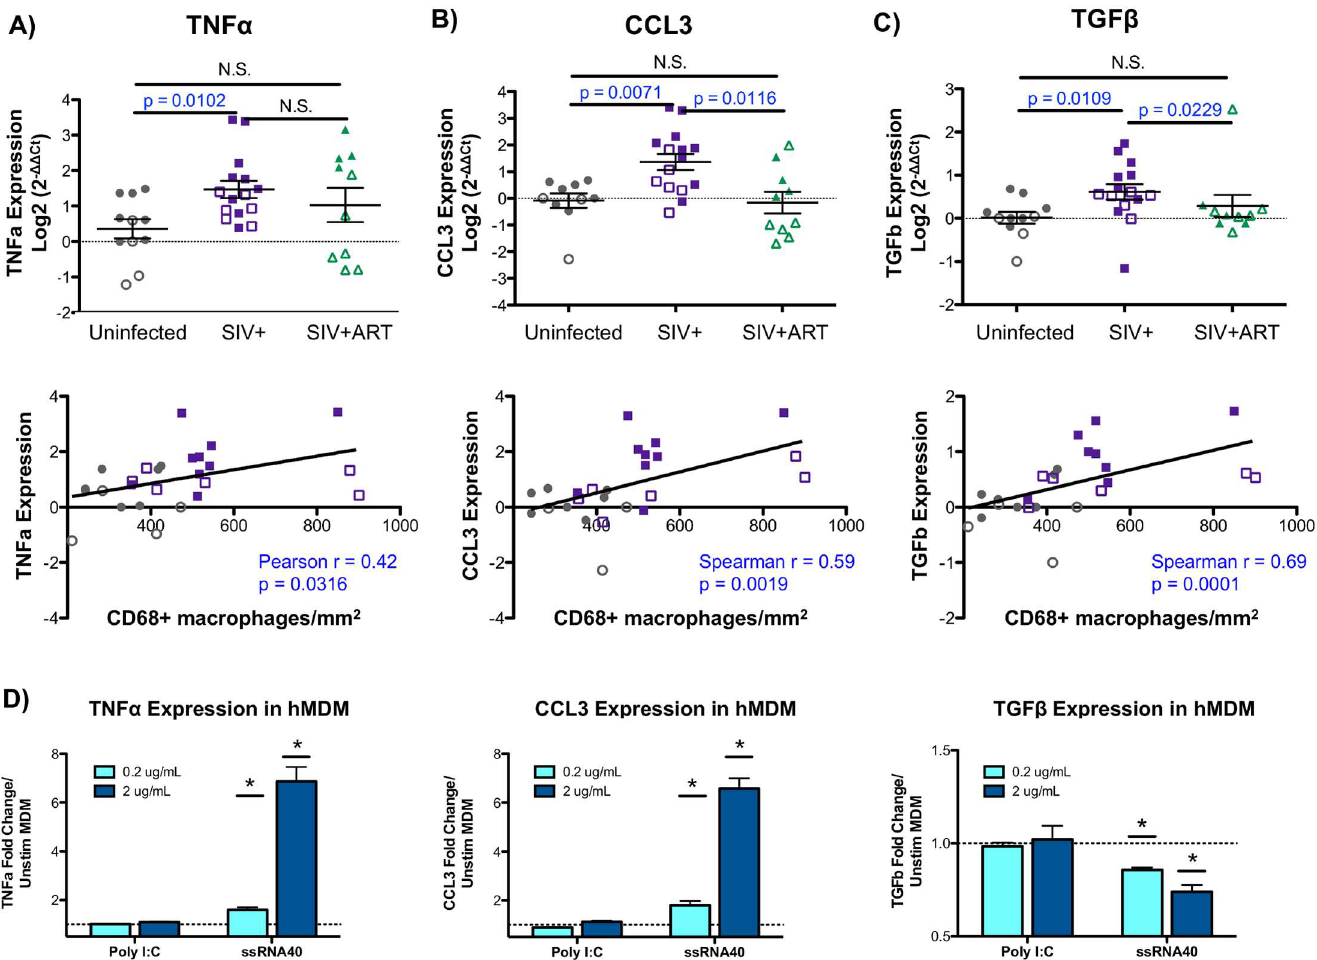
Fig 9. Liver macrophage number correlates with inflammatory and fibrosis mediators. A-C) Quantitative PCR was used to evaluate the hepatic expression of macrophage-associated chemokines and cytokines using the comparative threshold method. Data are graphed as the Log2 transformed mean ± SEM with adult (open symbols) and infant (closed symbols) macaques are denoted in each graph. Statistical significance was determined by Mann Whitney T tests. Correlation analysis was used to evaluate the relationship of cytokine/chemokine expression with liver macrophage number. Data displaying normal distribution were analyzed by Pearson correlation with data not passing normality were assessed by Spearman correlation. A significant increase in TNF α (A) , CCL3 (B) , and TGF β (C) was observed in livers of SIV-infected macaques that positively correlated with liver macrophage number in the uninfected (gray points) and SIV-infected (purple points) macaques. D) Human monocyte-derived macrophages were stimulated with poly I:C or ssRNA40 at 0.2 and 2 ug/mL for 12 hours in duplicate. Relative expression of TNF α , CCL3 and TGF β was assessed by qRT-PCR comparing poly I:C and ssRNA40 stimulated cells to control (unstimulated) monocyte-derived macrophages. Data are graphed as the mean fold change in expression ± SEM. Statistical significance was determined using a Mann Whitney T tests comparing technical replicates of each condition to unstimulated cells with p (cid:20) 0.05 denoted as (cid:3) .